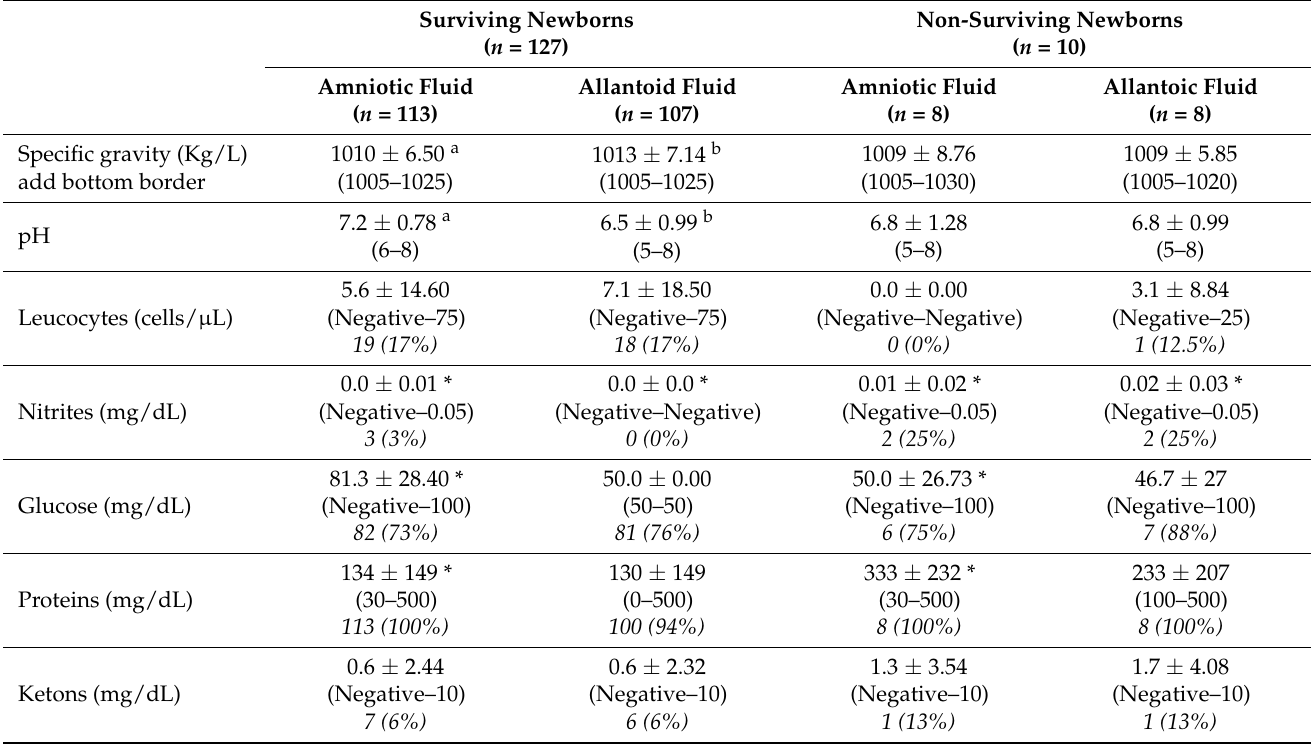
Table 1. Mean ± SD (range) and number and percentage of samples’ positivity (italic) for each strip parameter in amniotic and allantoic fluids of surviving and non-surviving